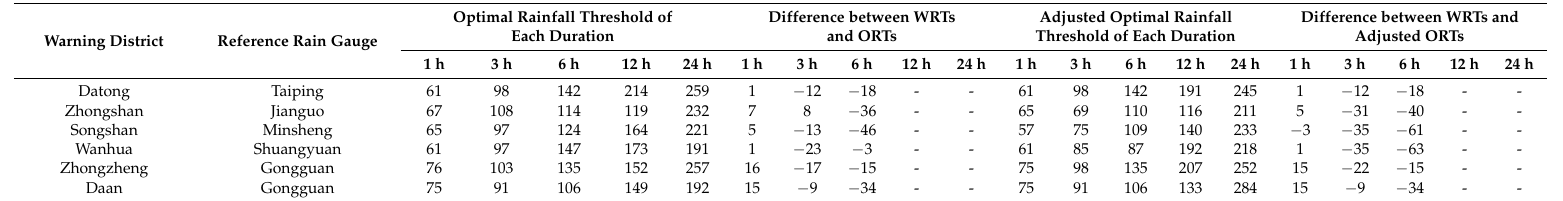
Table 4. Optimal and adjusted rainfall thresholds of 1-, 3-, 6-, 12- and 24-h durations.